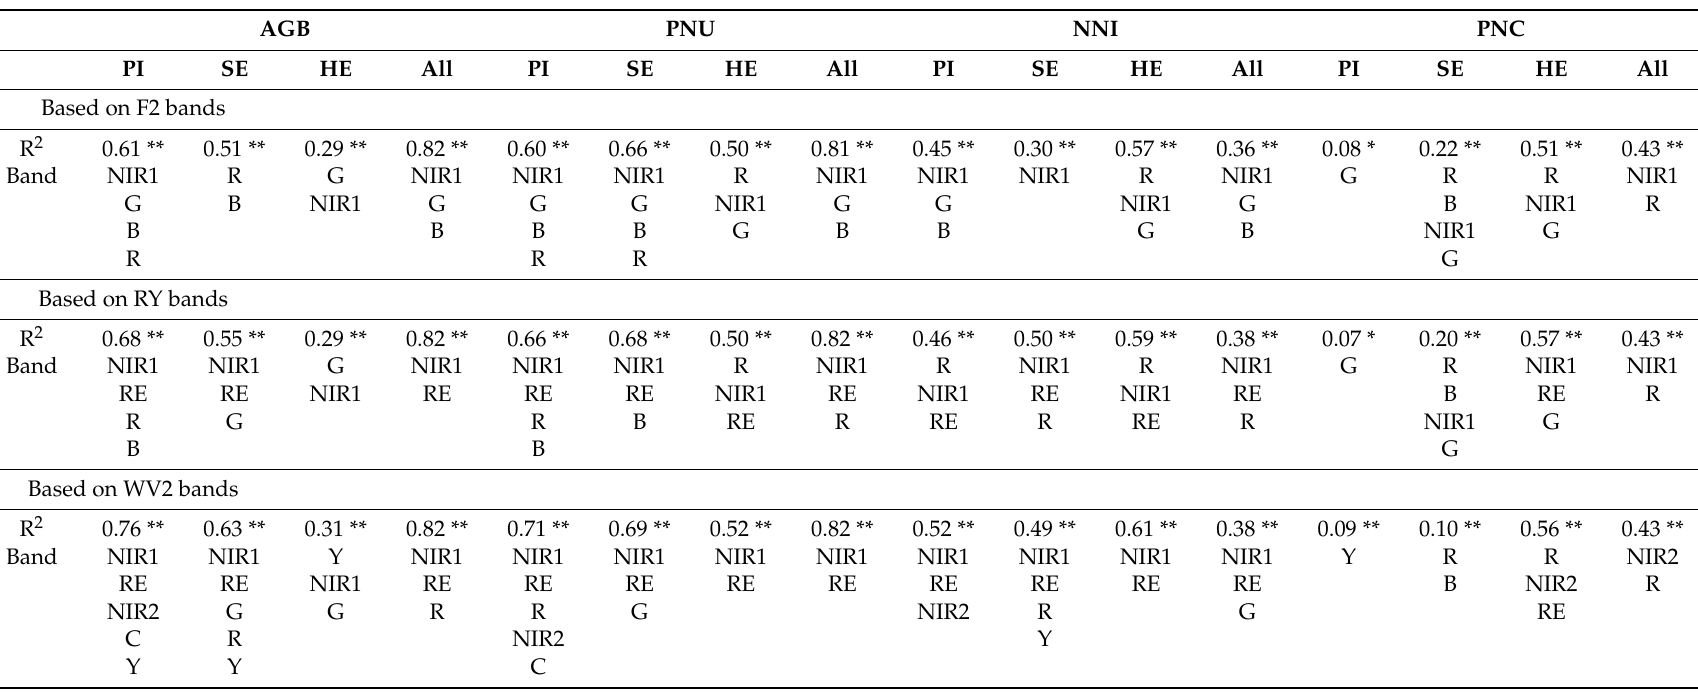
Table 7. Stepwise multiple linear regression models based on simulated multi-spectral FORMOSAT-2 (F2), RapidEye (RY), WorldView-2 (WV2) wavebands for estimating aboveground biomass (AGB) and plant N uptake (PNU), nitrogen nutrition index (NNI), and plant N concentration (PNC) at the panicle initiation